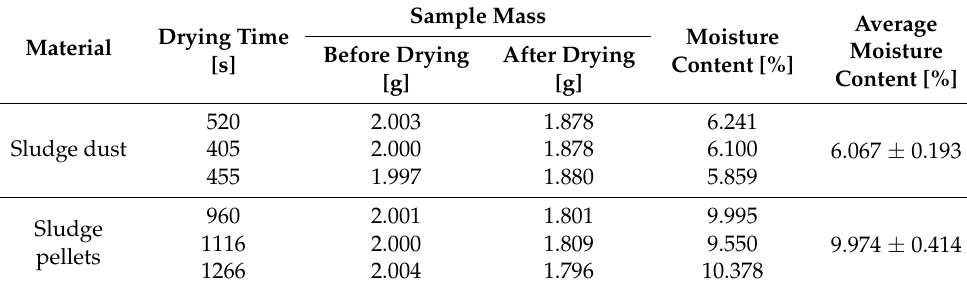
Table 1. The moisture content analysis results.